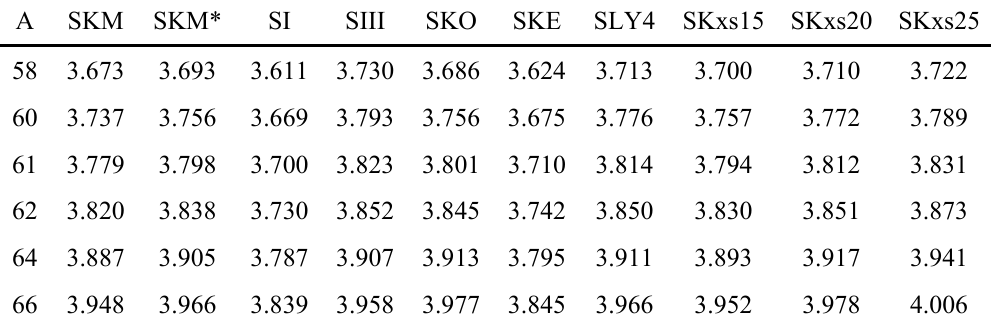
Table 4: Calculated neutron rms radii (fm) for the selected Ni-isotopes.